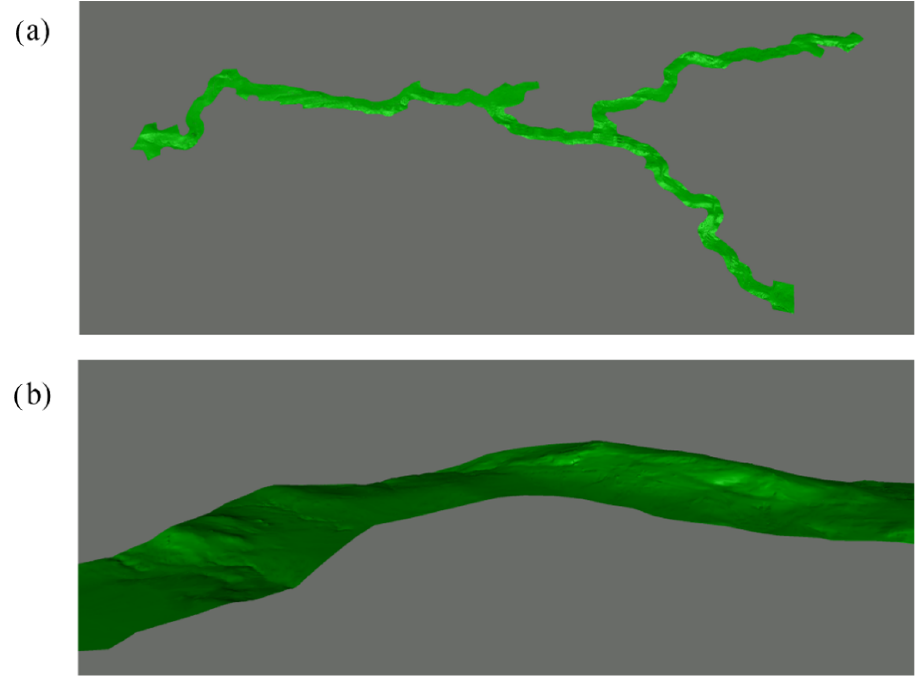
Figure 1. Digital terrain model (DTM). ( a ) DTM of the entire wind farm; ( b ) detail of the DTM in the study